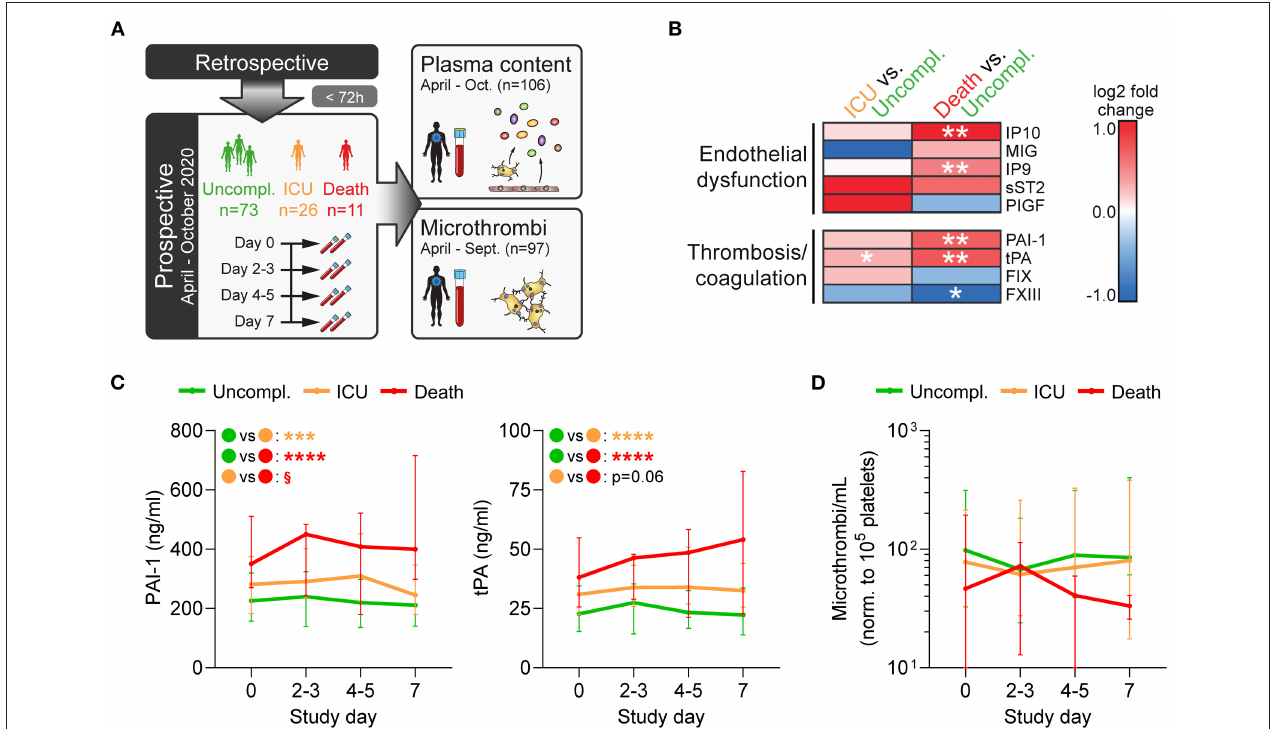
FIGURE 2 | Fatal disease is associated with disturbances of the coagulation system and vascular dysfunction. (A) Prospective study design: In a subcohort of the retrospective cohort comprising 110 patients (enrolled within 72h after hospital admission), blood was collected every 2–3 days over 1 week to assess plasma components and circulating microthrombi. (B,C) Plasma was analyzed by multiplex analysis for factors involved in endothelial dysfunction or thrombosis/coagulation. (B) Heatmap shows log2-fold changes in expression profiles of ICU patients or non-survivors relative to uncomplicated cases in plasma obtained at day 0. Differences were tested using two-sided Wilcoxon rank sum test. (C) Plasma levels of PAI-1 (left) and tPA (right) were monitored over 1 week after study entry using bead-based multiplex assay. Differences between outcome groups were tested by mixed-effects model with Geisser-Greenhouse correction. Asterisks (*) indicate significant differences to uncomplicated, section signs ( § ) indicate significant differences between ICU and death. n = 106 patients. (D) Circulating microthrombi in whole blood were monitored over 1 week after study entry by flow cytometry. n = 97 patients. * p < 0.05, ** p < 0.01, *** p < 0.001, **** p < 0.0001; § p <